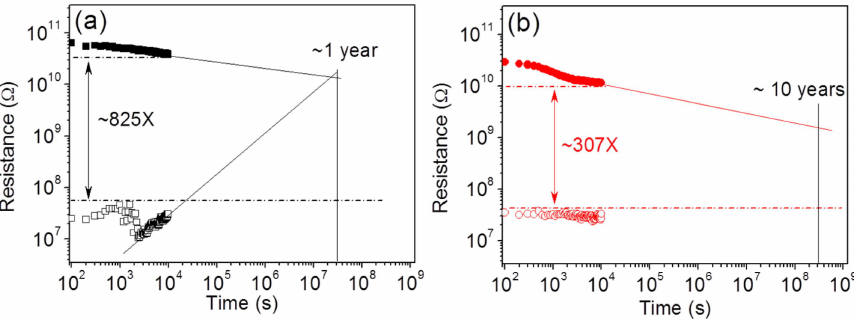
Figure 5. Data retention of the ZnO NW–based memories ( a ) without and ( b ) with argon plasma